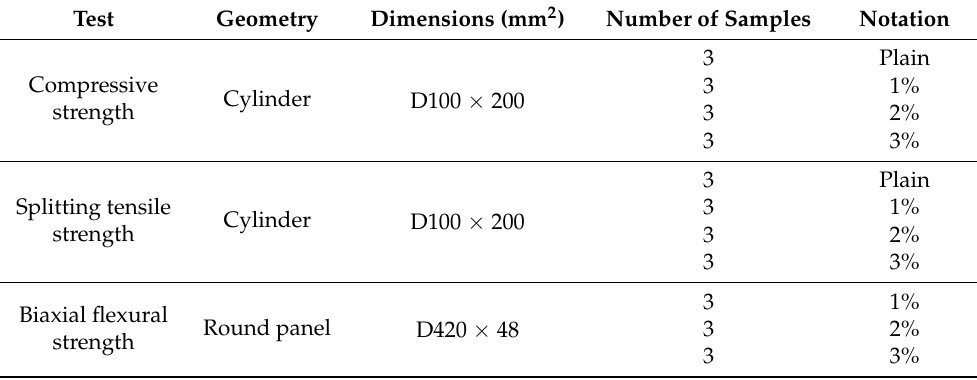
Table 5. Summary of test